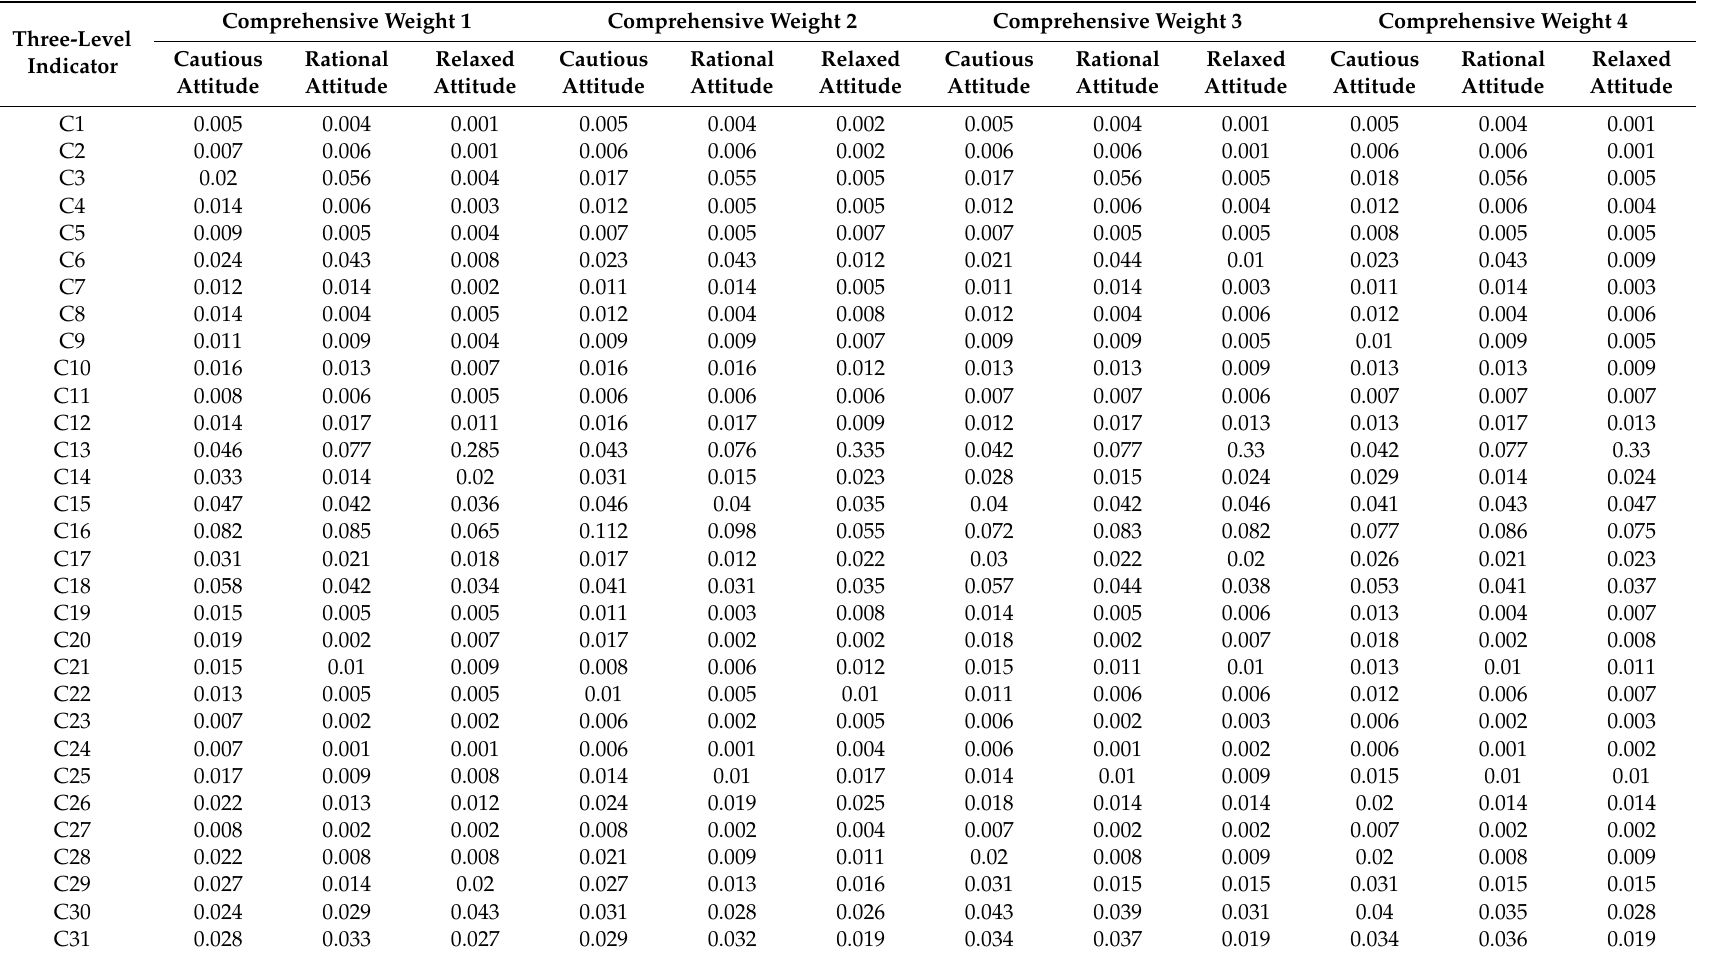
Table 3. Comprehensive weights of expert group for Pb-Zn mine safety